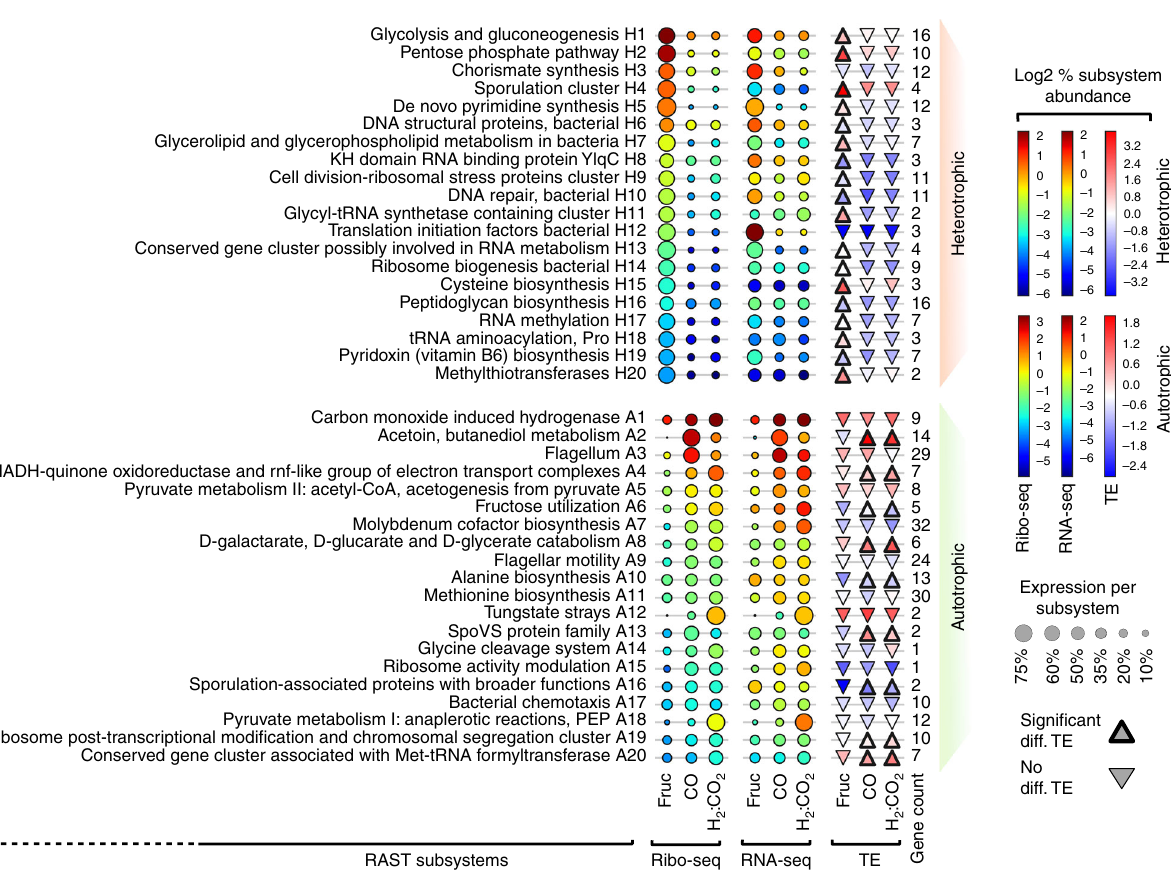
Fig. 2 Differential translation and differential TE of subsystems in fructose, CO and H 2 :CO 2 growth cultures. Genes were grouped into RAST subsystems and translation and transcription were both percent-normalized per each experiment. Each column represents the level of translation or transcription (% normalized) per each experiment and the bubble color re fl ects the intensity (% normalized). Each row represents a comparison between the three datasets and the size of bubbles represents the level of translation or transcription per each subsystem (% normalized). TE is compared per each subsystem and depicted by triangles. Subsystems with differentially increased TE are depicted by up-pointing triangle with thick edges and the colors represent percent- normalized values across the three conditions. The number of genes is shown per each subsystem. The top panel manifests the top 20 subsystems that are differentially upregulated ( P < 0.01) at the translational level in fructose (heterotrophic) relative to both autotrophic conditions and the data are sorted according to percent translation in fructose. The bottom panel manifests subsystems that are differentially upregulated ( P < 0.01) at the translational level in both autotrophic conditions with data sorted in descending order according to percent translation levels in CO. All values are shown as log